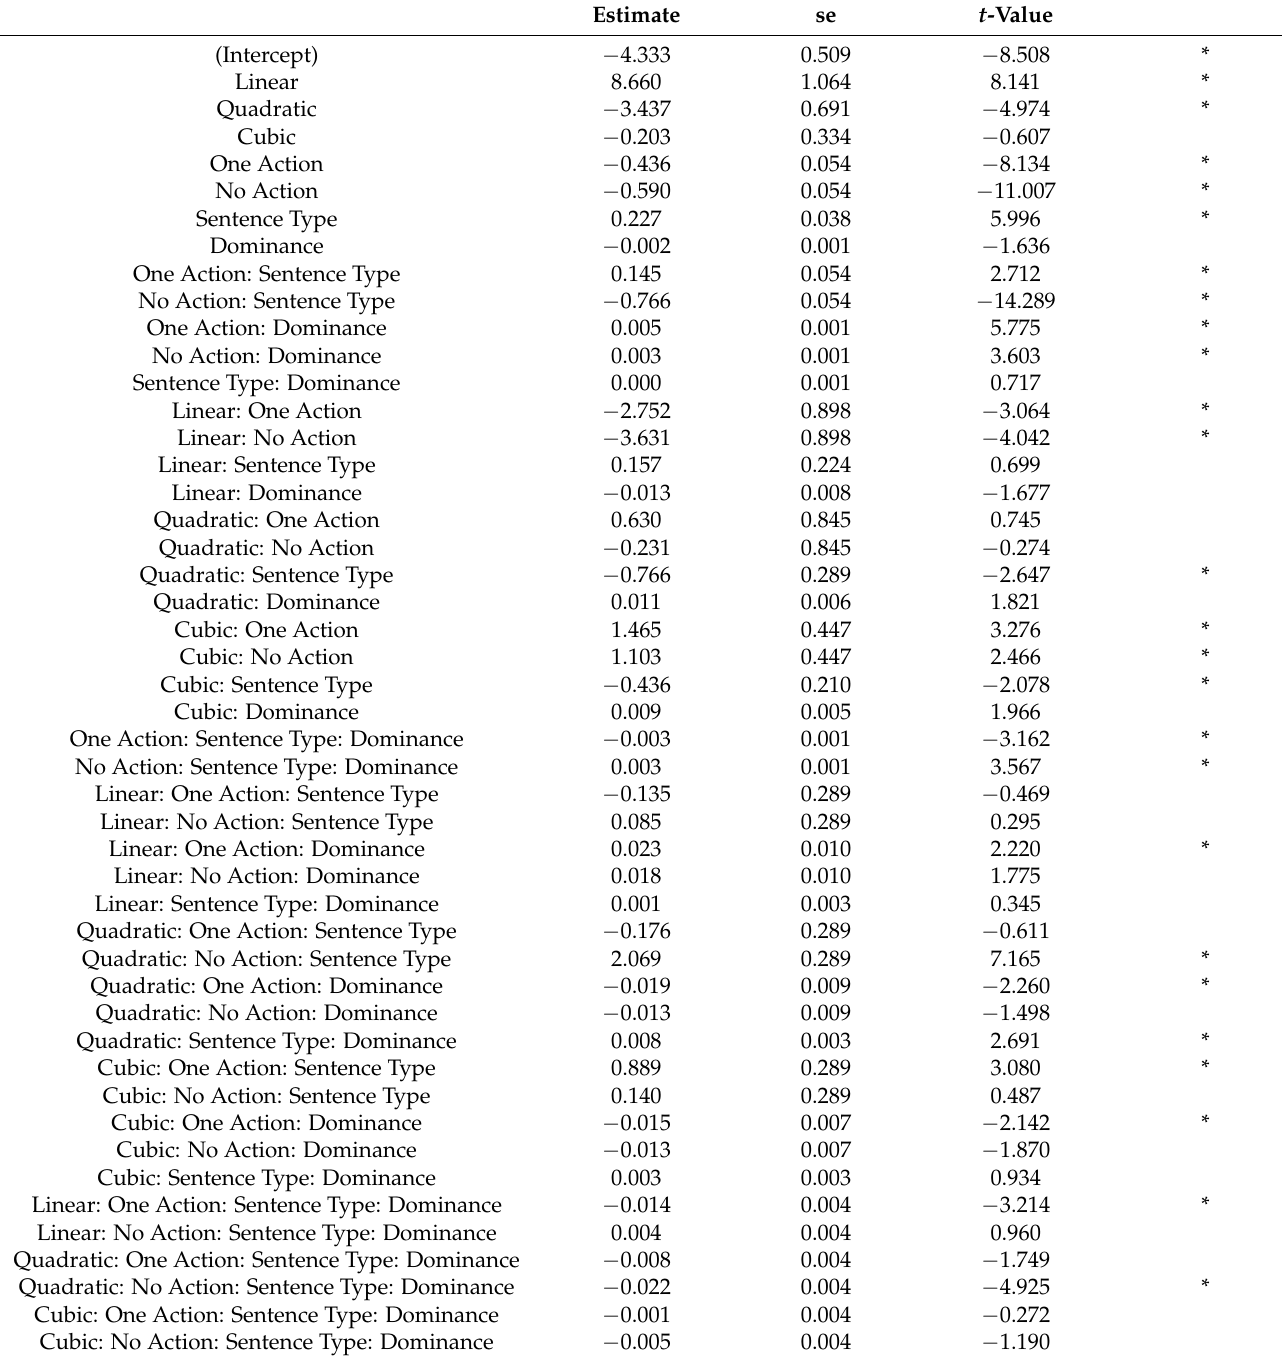
Table A1. Main and interaction effects in the quasi-logistic GCA mixed-model analysis for the anticipation